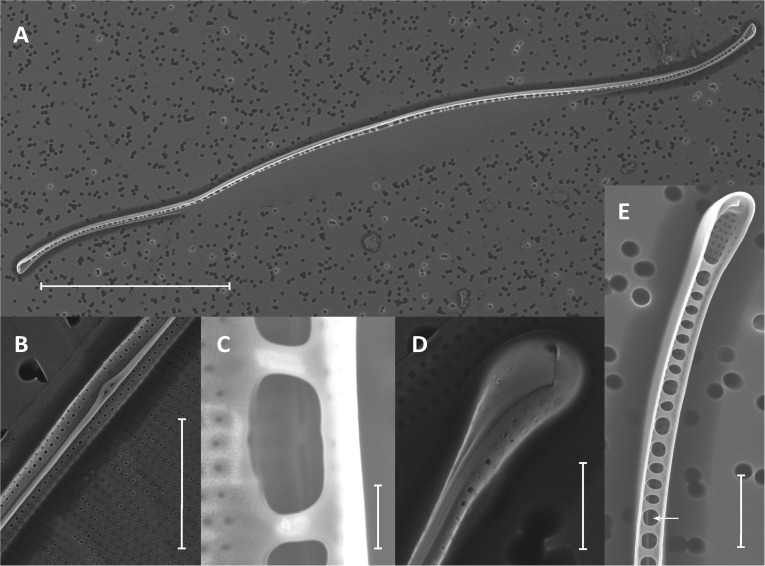
Morphological identification of Nitzschia longissima using SEM. (A) Interior of a single valve with eccentrically placed, rib-like fibulae and lanceolate ends; scale bar = 20 μm. (B) Exterior of the elevated and eccentrically placed raphe and raphe ends at the midpoint of the valve (main body of valve is collapsed); scale bar = 2 μm. (C) Interior raphe canal and ends between and behind two fibulae; scale bar = 500 nm. (D) Exterior of the apical end of the valve and terminal raphe fissure; scale bar = 1 μm. (E) Interior view of raphe canal (arrow) and helictoglossa (terminal end of valve canal) with fused fibulae; scale bar = 2 μm.